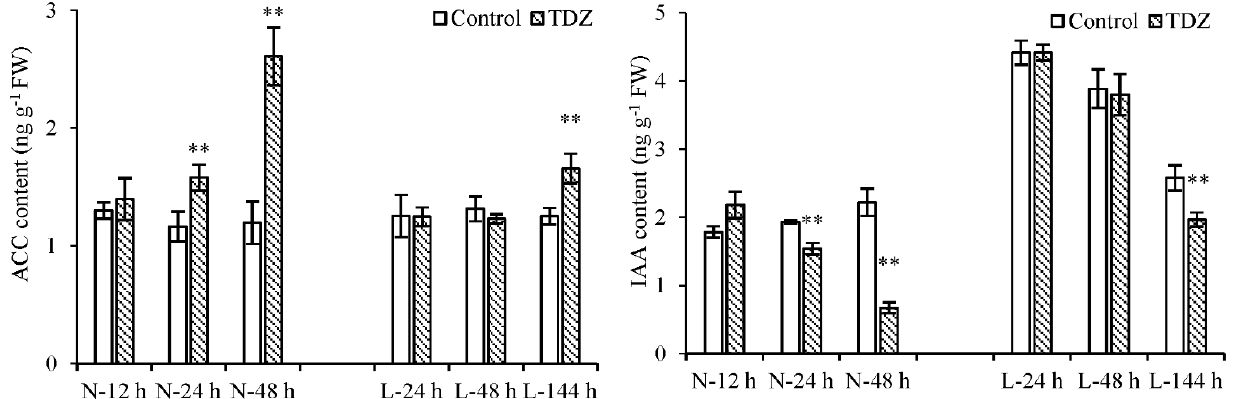
Figure 7. The contents of ACC and IAA in cotton AZs treated with TDZ and water (control) at different temperatures. Error bars represent the SD of three biological replicates. ** p < 0.01, Student’s t -test. IAA-amido hydrolase ( ILR ) and IAA-synthesis ( YUCCA ) genes were